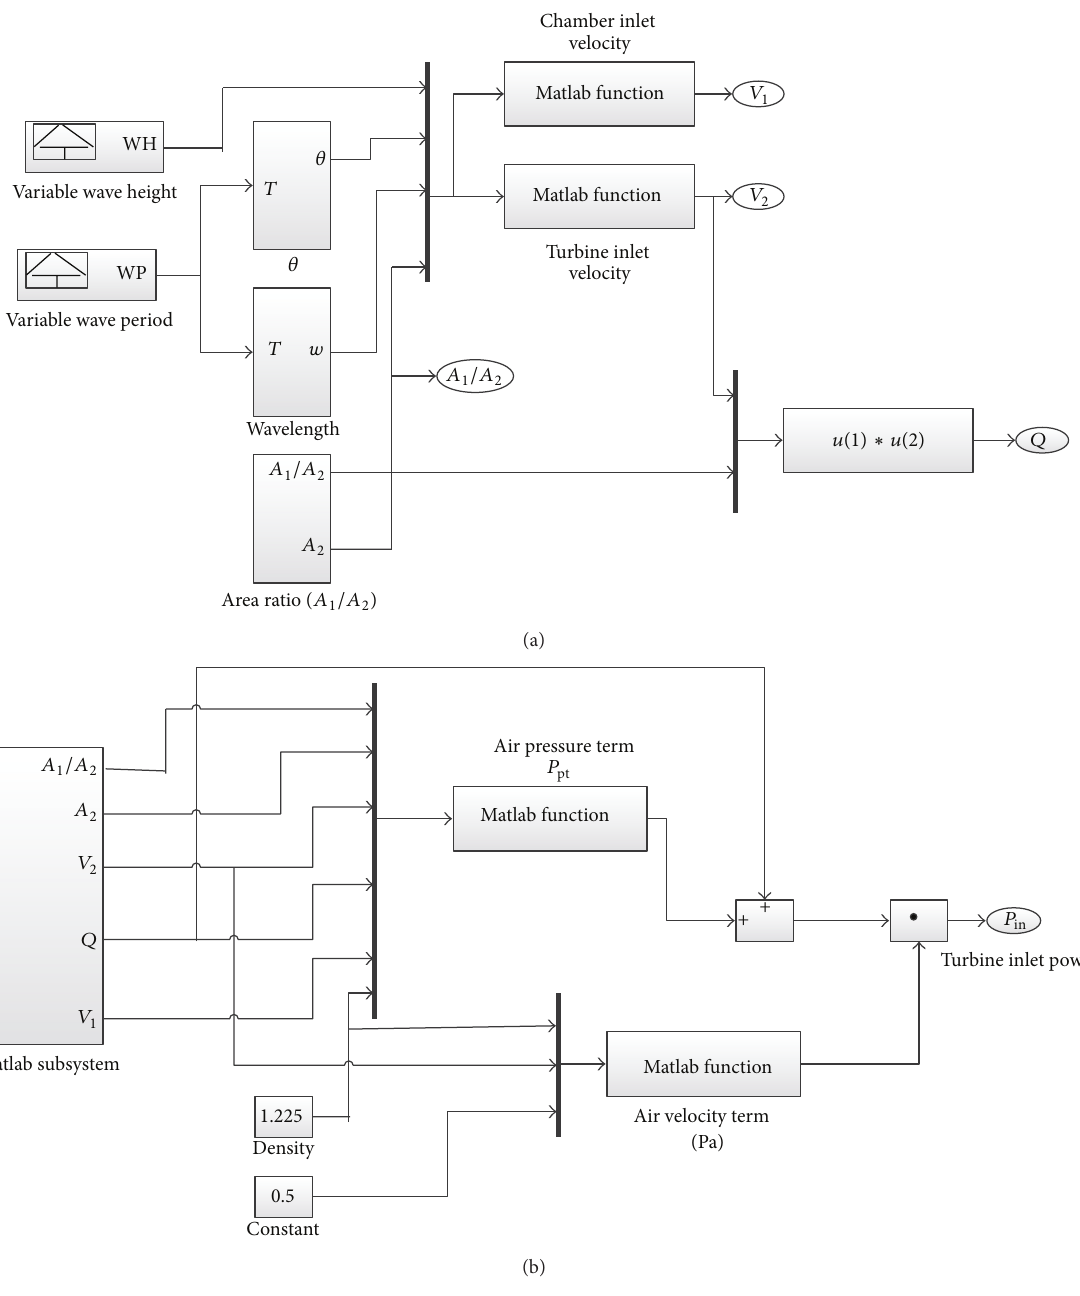
Figure 8: The Simulink diagram of the OWC model.